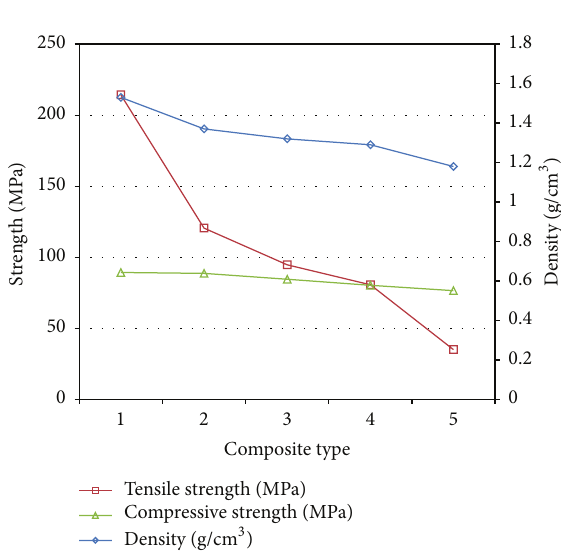
Figure 7: Trend of tensile strength, compressive strength, and density of composites with changing number of core kenaf